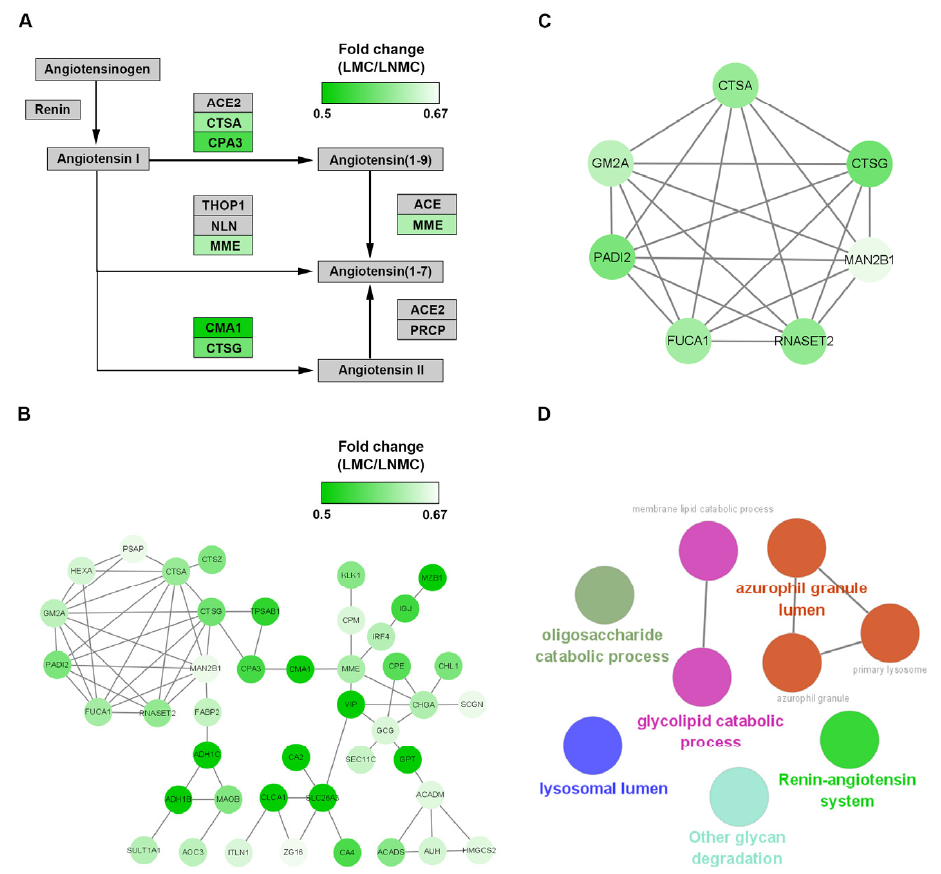
Figure 7. Pathways and protein–protein interaction network analysis of downregulated differentially expressed proteins (DEPs) in LMC. ( A ) KEGG pathway analysis of the LMC-specific downregulated DEPs. ( B ) The LMC-specific downregulated DEPs in the protein–protein interaction networks are shown as nodes (MS data presented as 128/130 ratios were matched to STRING networks). The depth of the green color indicates the ratio of protein abundance in LMC/LNMC. ( C ) The downregulated hub genes identified by the MCODE plug-in. ( D ) Functional analysis of the seven hub DEPs using the ClueGO plug-in by Cytoscape.